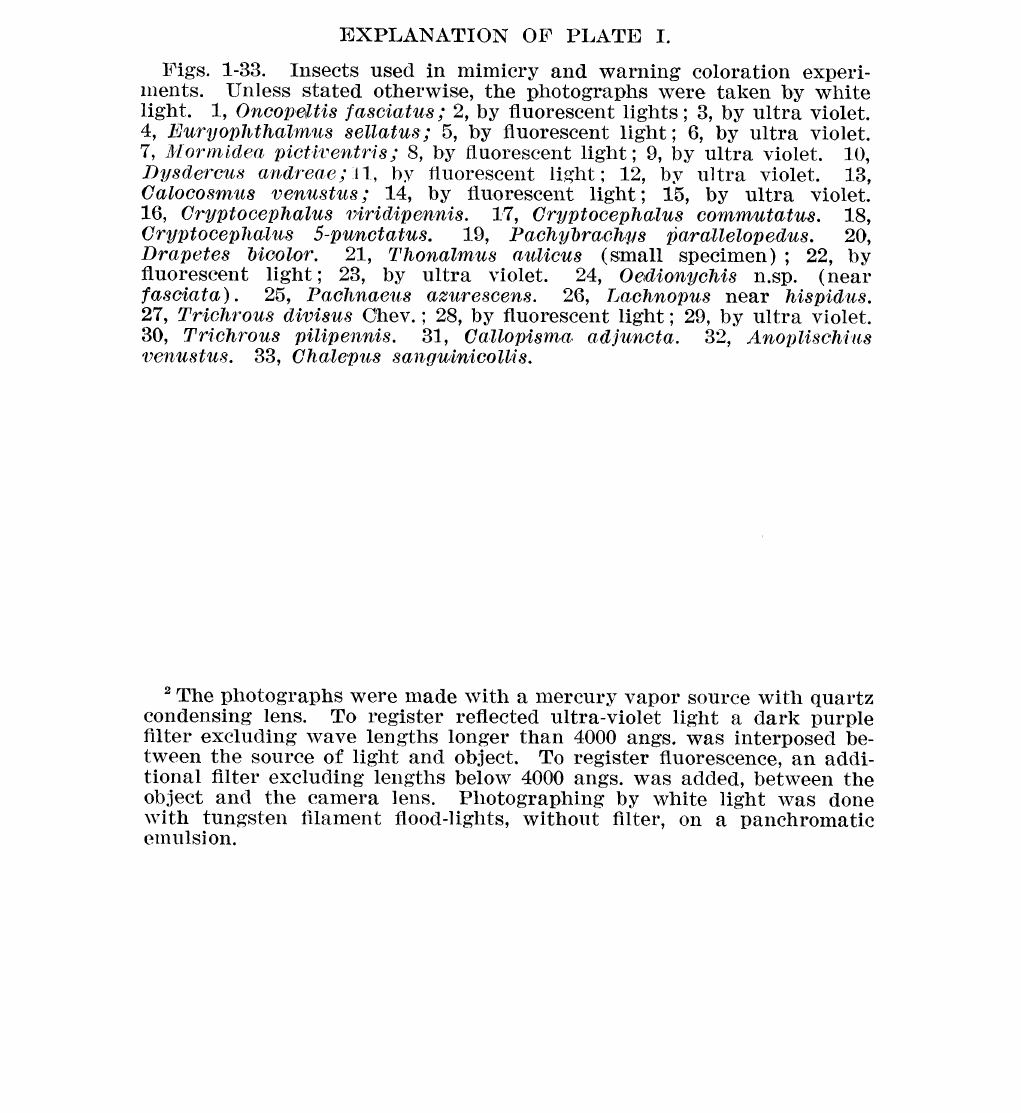
Figs. 1-33. Insects used in mimicry and warning coloration experi- merits. Unless stated otherwise, the photographs were taken by white light. 1, Onvope,ltis fasciatus; 2, by fluorescent lights; 3, by ultra violet. 4, Euryophthalmus sellatus; 5, b.y fluorescent light; 6, by ultra violet. 7, Mormidea pictiventris; 8, by fluorescent light; 9, by ultra violet. Dysdercus a1dreac;Jl, by fluorescent light; 12, by ultra